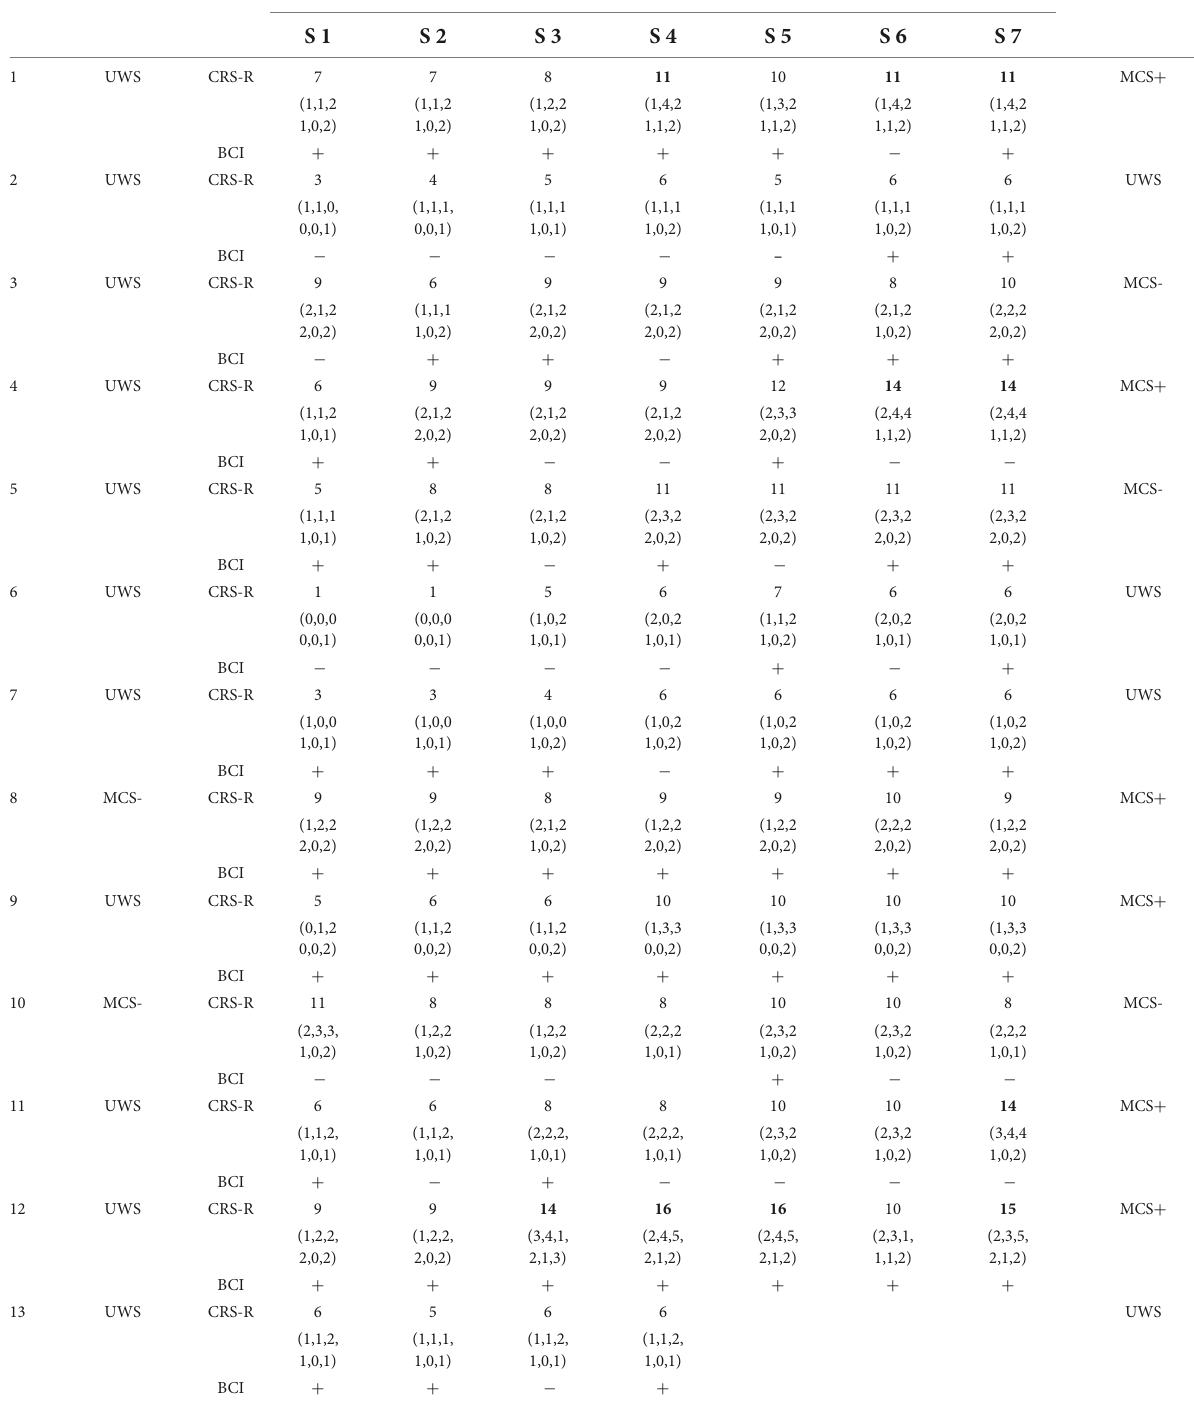
TABLE 2 Results from clinical and neurophysiological repetitive assessments. PT Early